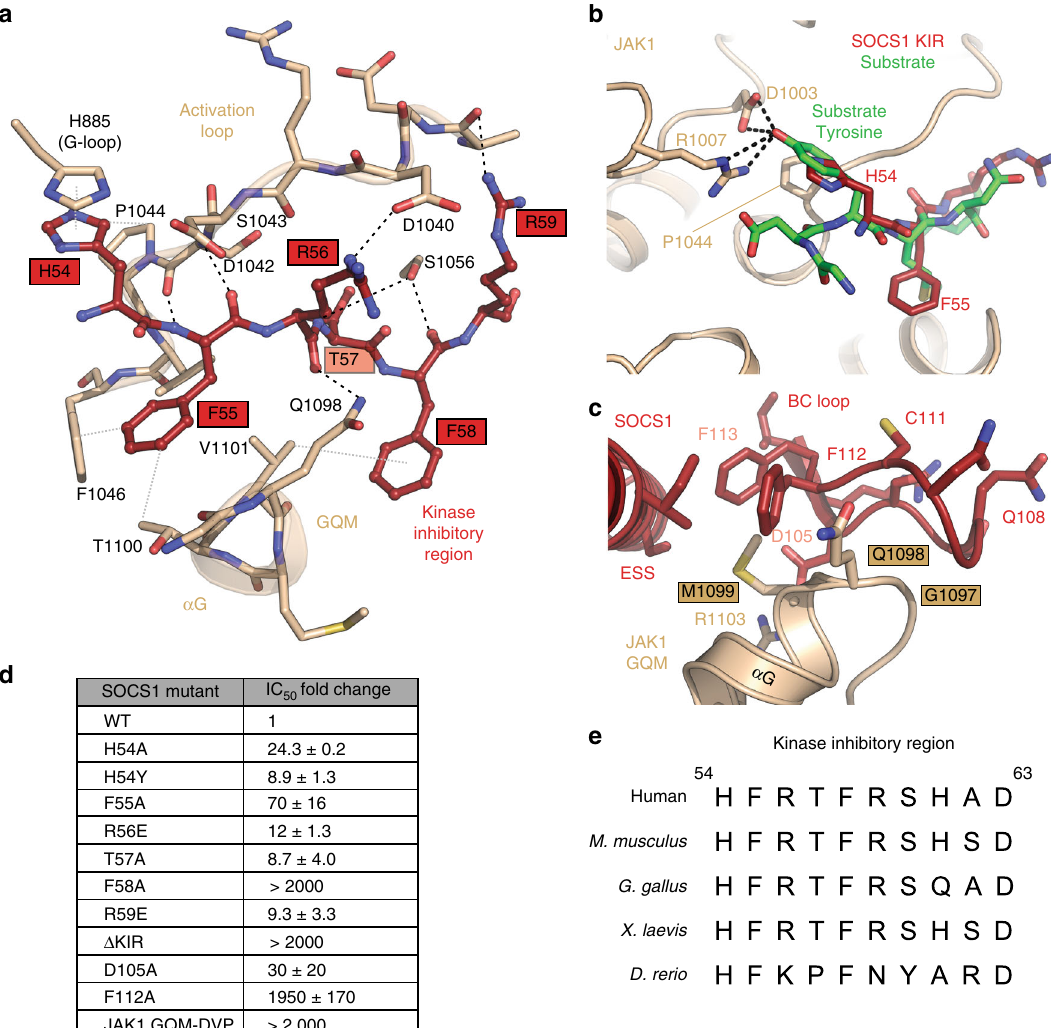
Fig. 3 The kinase inhibitory region acts as a pseudosubstrate. a Molecular details of the interaction between the SOCS1 kinase inhibitory region (red) and JAK1 (beige). The interaction is driven by six continuous residues in the SOCS1 KIR (His54 to Arg59), these primarily interact with the activation loop, GQM motif and glycine-rich loop of JAK1. Black dashed lines indicate hydrogen-bonds whilst grey dotted lines are van der Waals contacts. b A model of a peptide substrate (green) bound to the JAK1 kinase domain (based on the insulin receptor kinase/substrate structure (PDB: 1IRK)) indicates that the SOCS1 KIR acts as a pseudosubstrate with His54 mimicking the substrate tyrosine. c The GQM motif (Gly1097, Gln1098, Met1099) in JAK1 is a primary interaction site with SOCS1 and contacts the KIR, extended SH2 subdomain and SH2 domain (particularly the BC loop). d IC 50 values of SOCS1 KIR mutants indicate that each residue of the KIR contributes to the af fi nity of the interaction. Errors are standard error of the mean from two independent experiments. e Sequence alignment of the KIR of SOCS1 from various species shows a high level of sequence